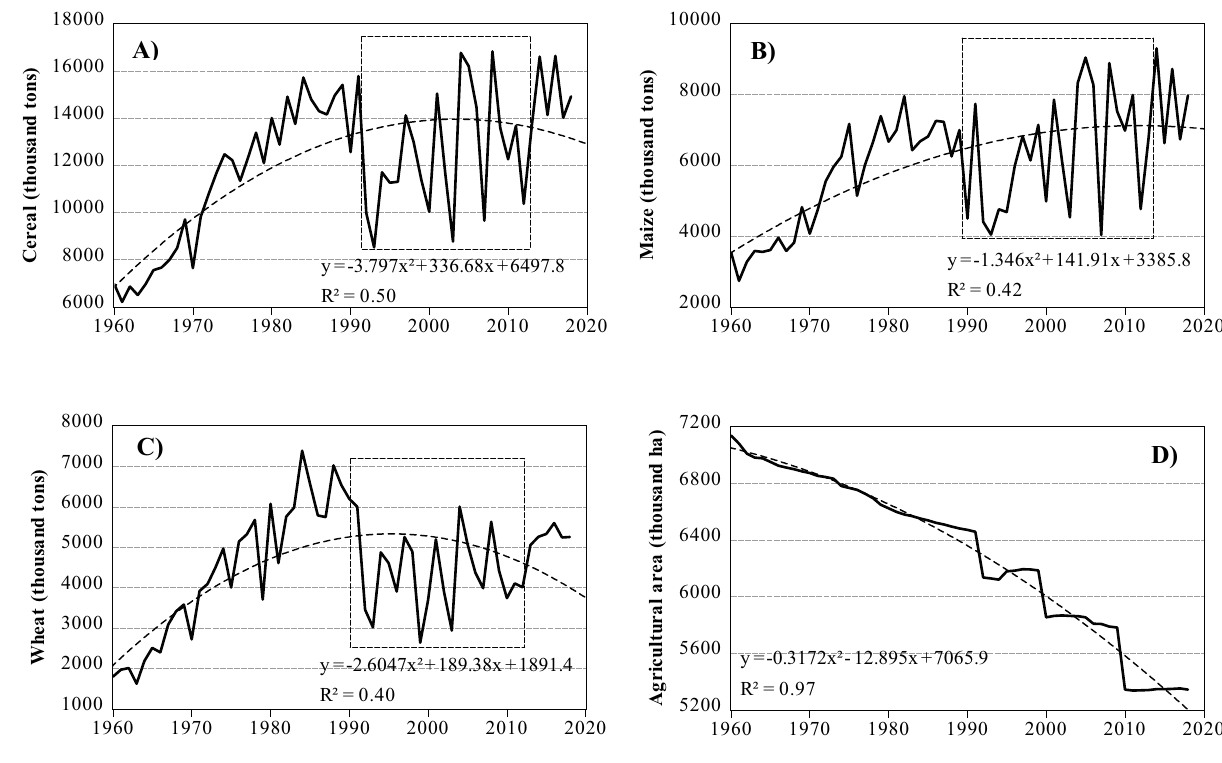
Figure 1. An overview of main crop production in Hungary between 1960 and 2018. ( A ) Cereal production (thousand tons), ( B ) Maize production (thousand tons), ( C ) Wheat production (thousand tons), ( D ) Agricultural lands (ha) (figure was generated using EViews (https:// www. eviews. com/ home.